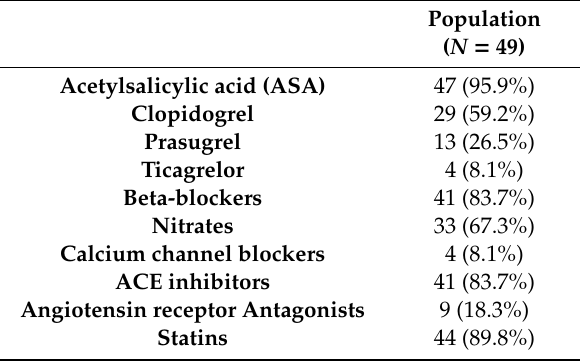
Table 2. Medical therapy at baseline (BL).